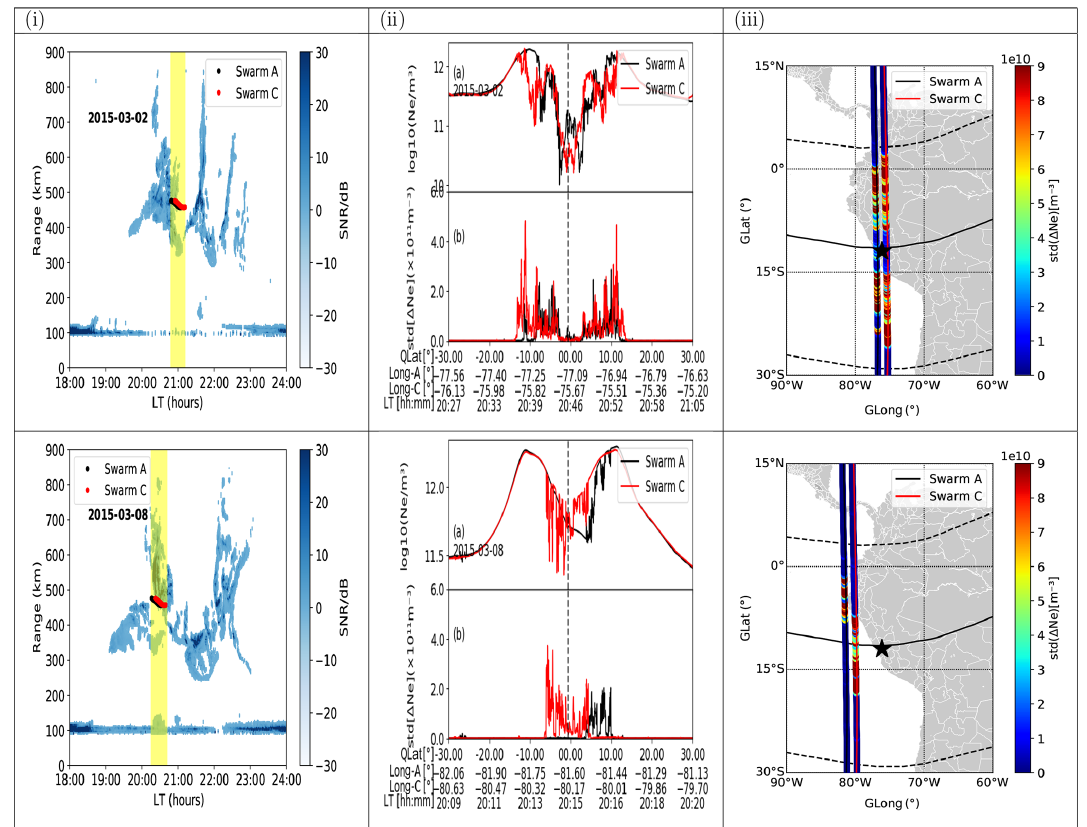
Figure 4. Examples of co-located observations by Swarm and the JULIA radar on 2 and 8 March 2015. The local time coverage and the corresponding altitude of Swarm while orbiting over or near the JRO are (black for Swarm A, and red for Swarm C) shaded yellow in column (i). The QLat of the JRO is indicated using a vertical dotted black line in column (ii). The ground tracks of Swarm and the location of the JRO are shown on the maps in column (iii). The thick black line in column (iii) shows the geomagnetic equator, and the dotted black lines show the EIA belts ( ± 15 ◦